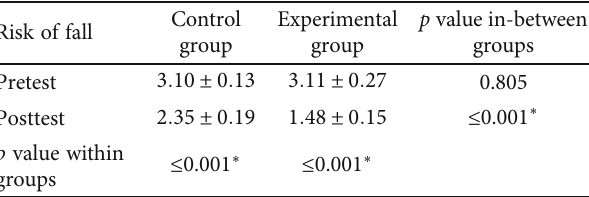
Table 3: Risk of fall within and in-between groups.